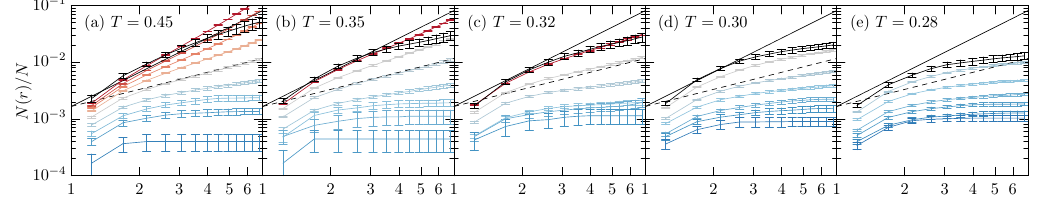
Figure 4: The fraction of particles N ( r ) / N up to a distance r for unstable modes of saddles. All parameters are the same as in Fig. 3, but we do not show the data with λ < − 21.25 at T = 0.45, λ < − 16.25 at T = 0.35, and λ < − 13.75 at T ≤ 0.32 for visualization purposes. The dashed and solid lines show power laws with the fractal dimensions D = 1 and 2,